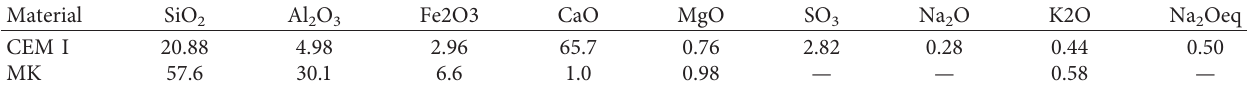
Table 1: Chemical analysis of OPC and MK.